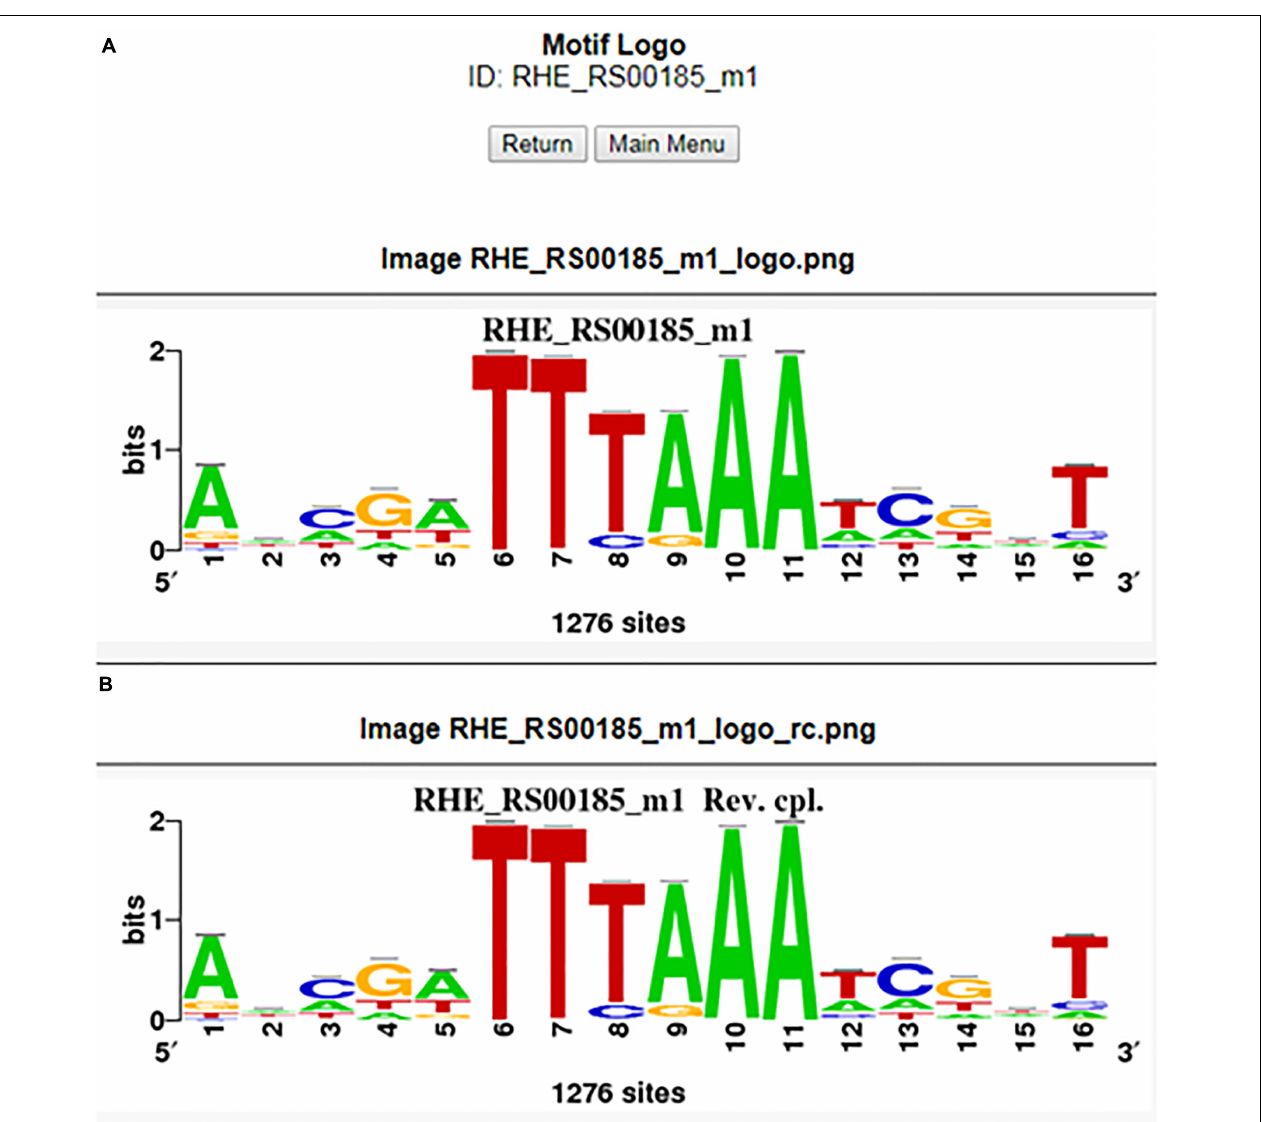
FIGURE 4 | Motif logo from the RHE_RS00185_m1 matrix for the forward (A) and reverse (B) complementary strands.